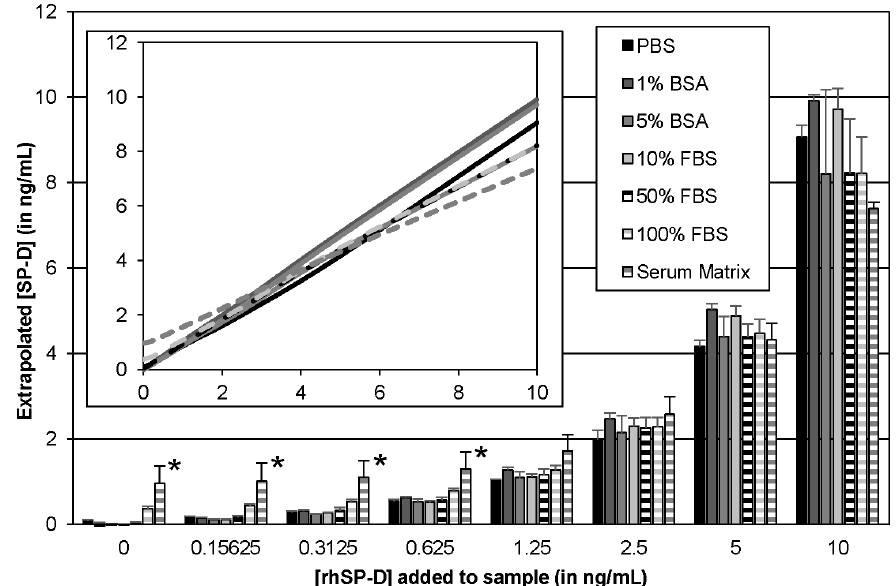
Figure 2. Use of various diluents for the recombinant SP-D standard. A 1 m g/mL recombinant SP-D stock was diluted 1:99 in various matrices and then serially diluted 2 fold in the same matrix. Mean and standard deviation for three independent experiments are shown. An asterisk (*) denotes values are significantly different (p # 0.01) from both the 1% BSA and 10% FBS values by one-way ANOVA using Tukey’s multiple comparison test.